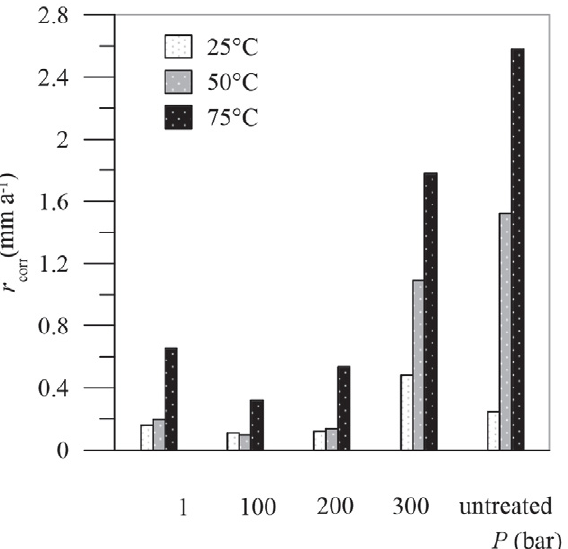
Figure 10. Corrosion rate for AISI 347 at 25 30 , 50 and 75 °C in de- pendence of pressure.